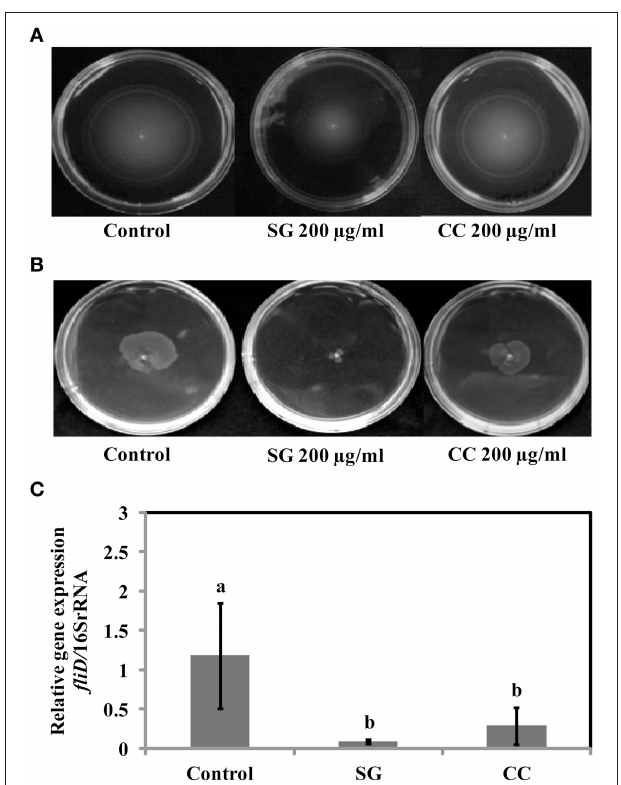
FIGURE 4 | Effect of SWE on the motility of bacteria. (A) SWE effect on S . Enteritidis swimming motility. Swimming motility of S . Enteritidis was determined by adding 200 µ l/ml SWE into the agar plates. Single purified colony was inoculated with a toothpick from an overnight TSA plate onto a swim plate (tryptone broth plus 0.3% agar) to observe for effect on motility after overnight incubation at 30 ◦ C. (B) SWE effect on S . Enteritidis swarming motility. S . Enteritidis showed deficient movement when inoculated onto swarm plates (Difco bacto-agar, 0.5% glucose) after 24h incubation at 30 ◦ C. (C) Effect of SWE on the relative gene expression of fliD gene required for polymerization of flagellin on the tip of growing flagella. Values represent Mean ± Standard deviation from three independent experiments; each experiment had three biological